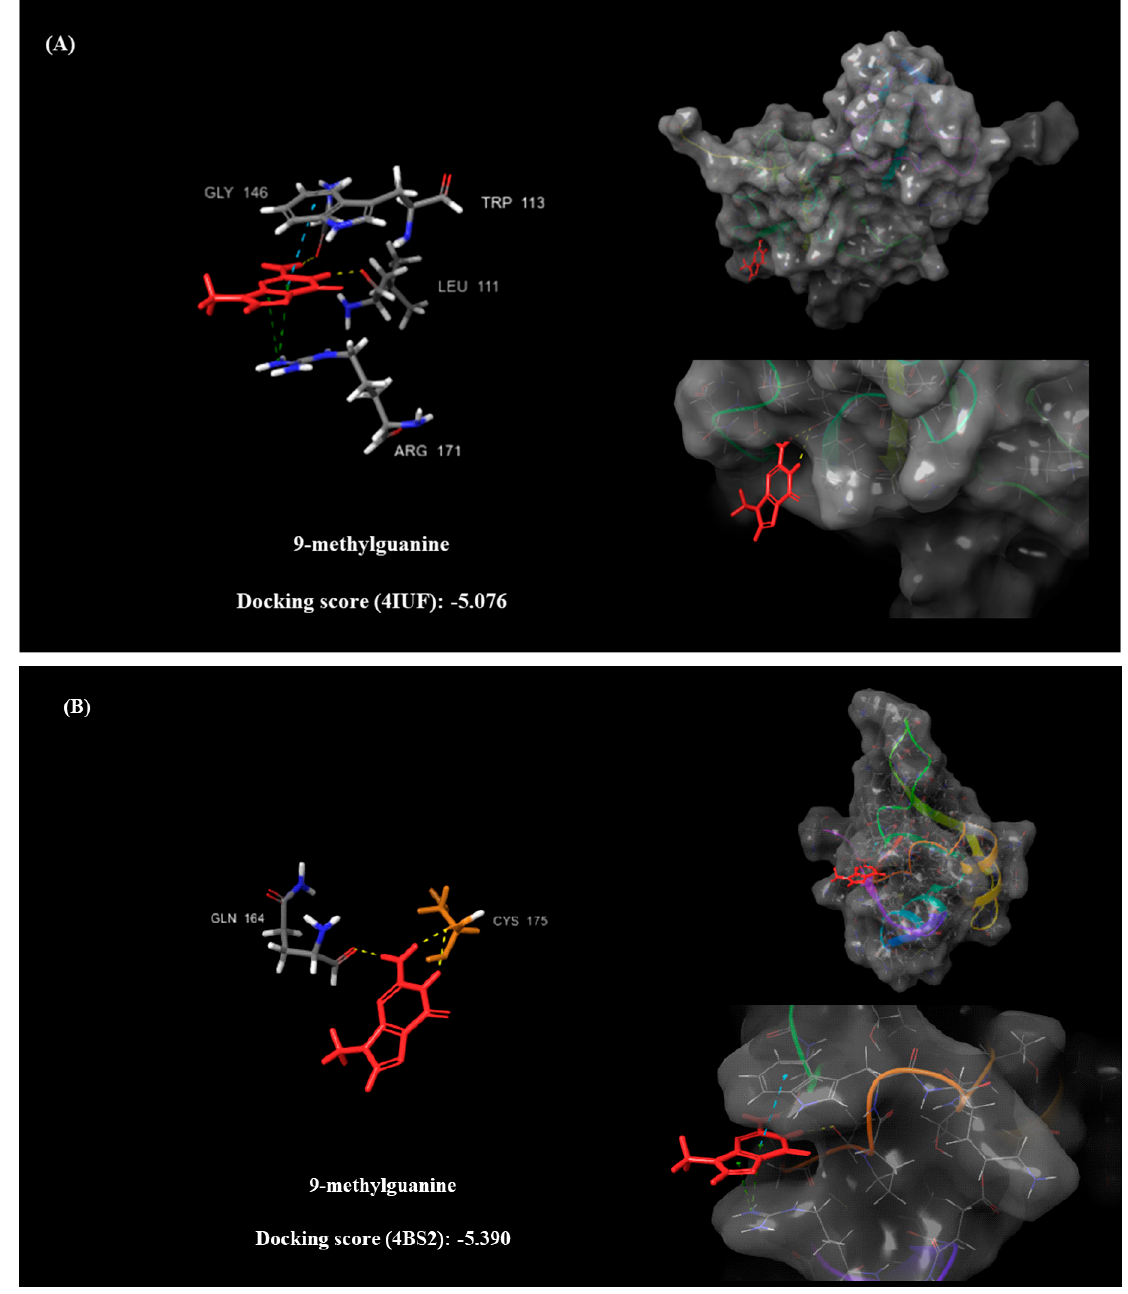
Figure 7. Docking pose and amino acid interaction on 4IUF ( A ) and 4BS2 ( B ) TDP-43 crystalized proteins of